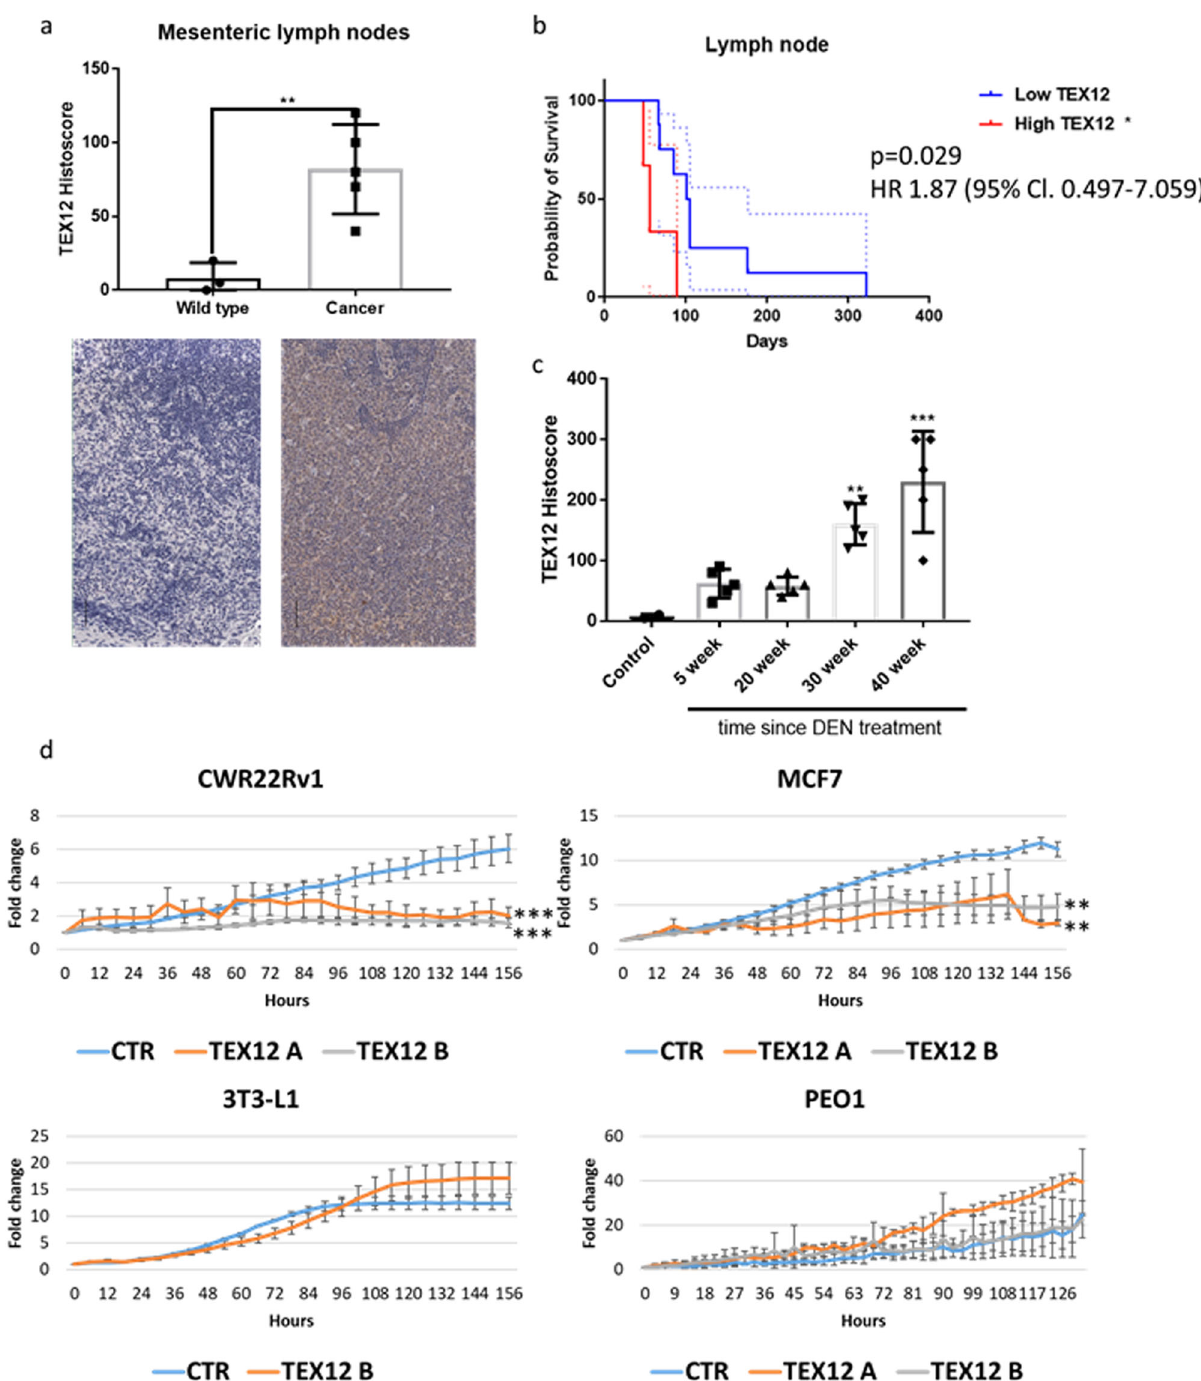
Fig. 6 TEX12 is expressed with the onset of cancer and is required for cancer cell proliferation. a E µ -Myc lymphoma and healthy controls mesenteric lymph nodes were stained and scored for TEX12 protein levels. Each data point indicates one animal ( n = 11). Black lines indicate 50 µ m. ** p < 0.01. Error bars represent standard deviation. b Kaplan – Meier survival curve of E µ -myc lymphoma mice divided based on their lymph node TEX12 protein histoscore. ( n = 11). 95% con fi dence intervals are indicated with dotted lines. c Mice have been scored for liver TEX12 protein levels following DEN-treatment tumour induction. Each data point represents one animal ( n = 22). Error bars represent standard deviation. d Cells were treated with control siRNA (CTR) or two TEX12 targeting sequences A or B (details in Methods section) and cell growth was measured in three independent experiments every 3 h with IncuCyte. * p < 0.05; ** p < 0.001; *** p < 0.005. Data are presented Materials and methods of centrosomal/MTOC localisation of a mammalian SC component. Antibodies and plasmids . The anti-TEX12 (ab122455), anti-pericentrin Thus, our fi ndings suggest a possibility for an evolutionarily con- served cross-talk between structural components of the mammalian SC and MTOCs.